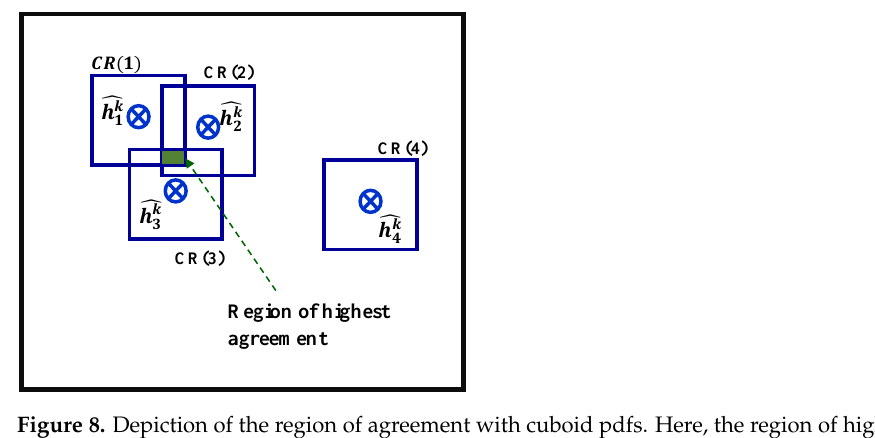
Figure 8. Depiction of the region of agreement with cuboid pdfs. Here, the region of highest overlap, depicted as the area shaded in green is the solution, will exhibit the peak value when the cuboid pdfs centered at (cid:98) h k , i = 1, 2, 3, and 4 are i